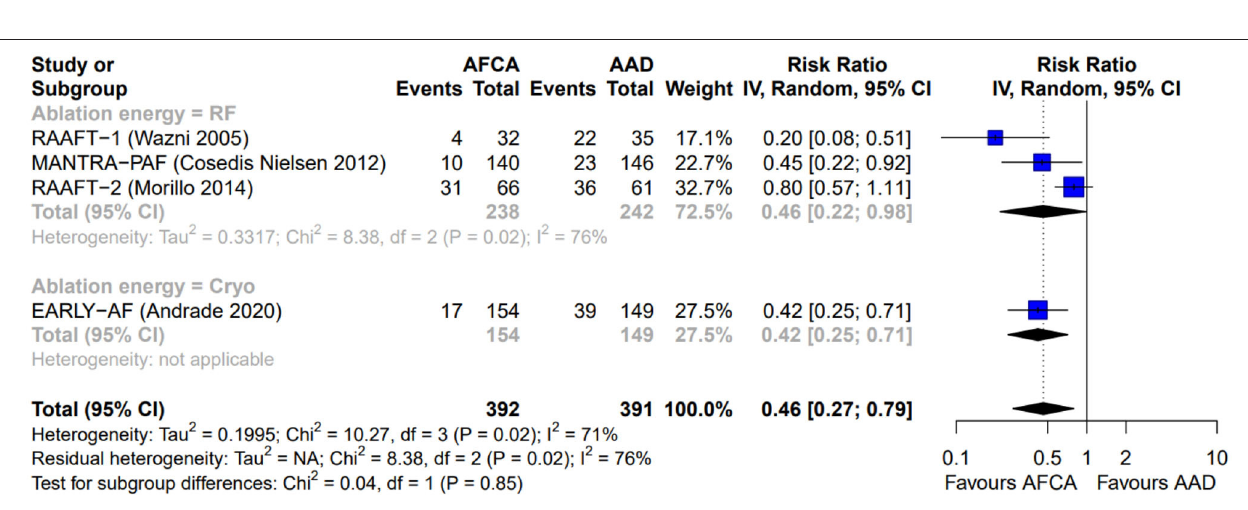
FIGURE 3 | Forest plot reporting the risk of recurrence of symptomatic atrial tachyarrhythmias, stratified by ablation energy (radiofrequency or cryoenergy).